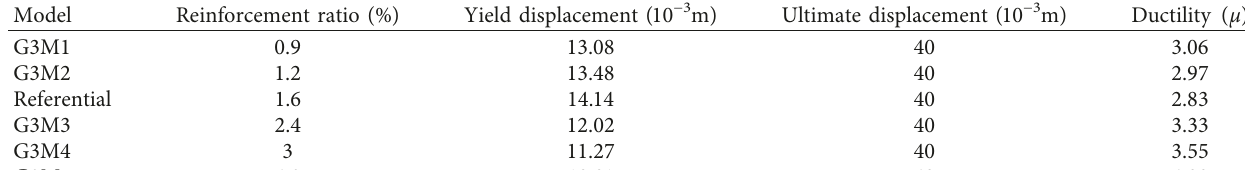
Table 14: Yield and ultimate displacement for ductility determination.